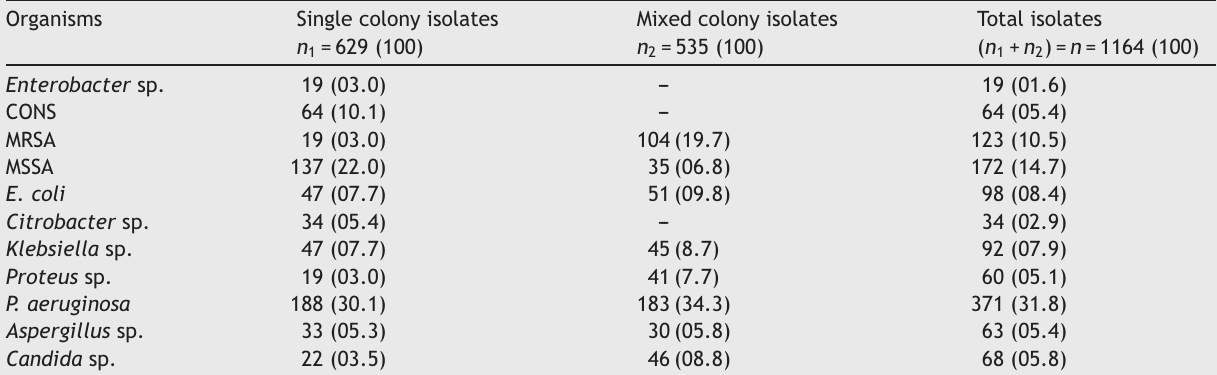
Growth of bacteria and fungi in cultures of ear discharge samples of OPD patients with CSOM as single colony and mixed colonies.